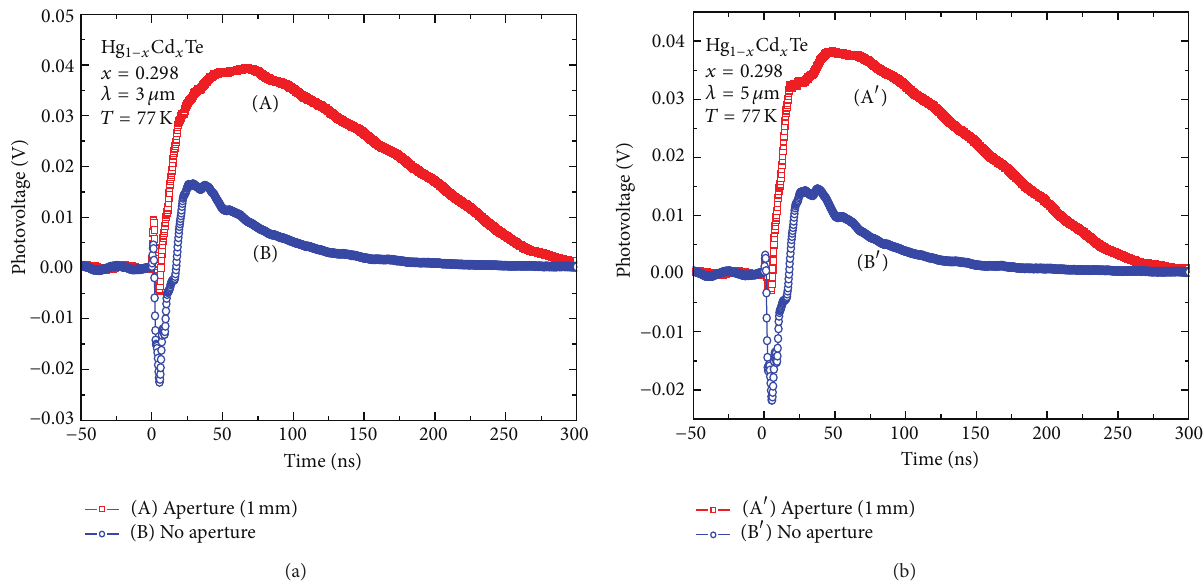
Figure 4: Transient PV response of the HgCdTe photodiode with no aperture and 1mm aperture added in the optical path for incident photon energy larger and smaller than the bandgap.